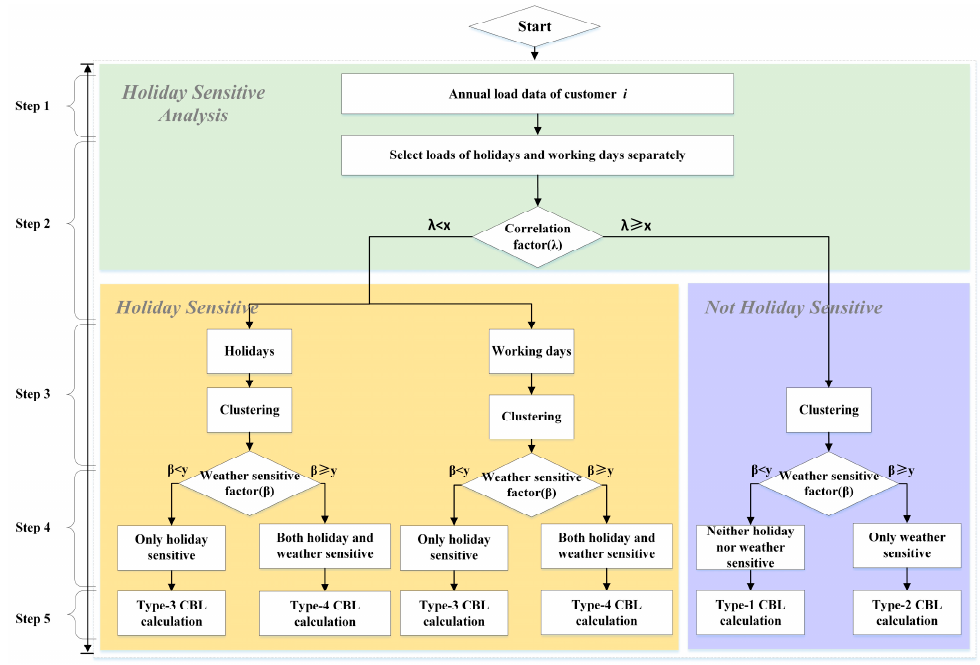
Figure 2. Framework of baseline calculation considering customer’s multiple power usage patterns.